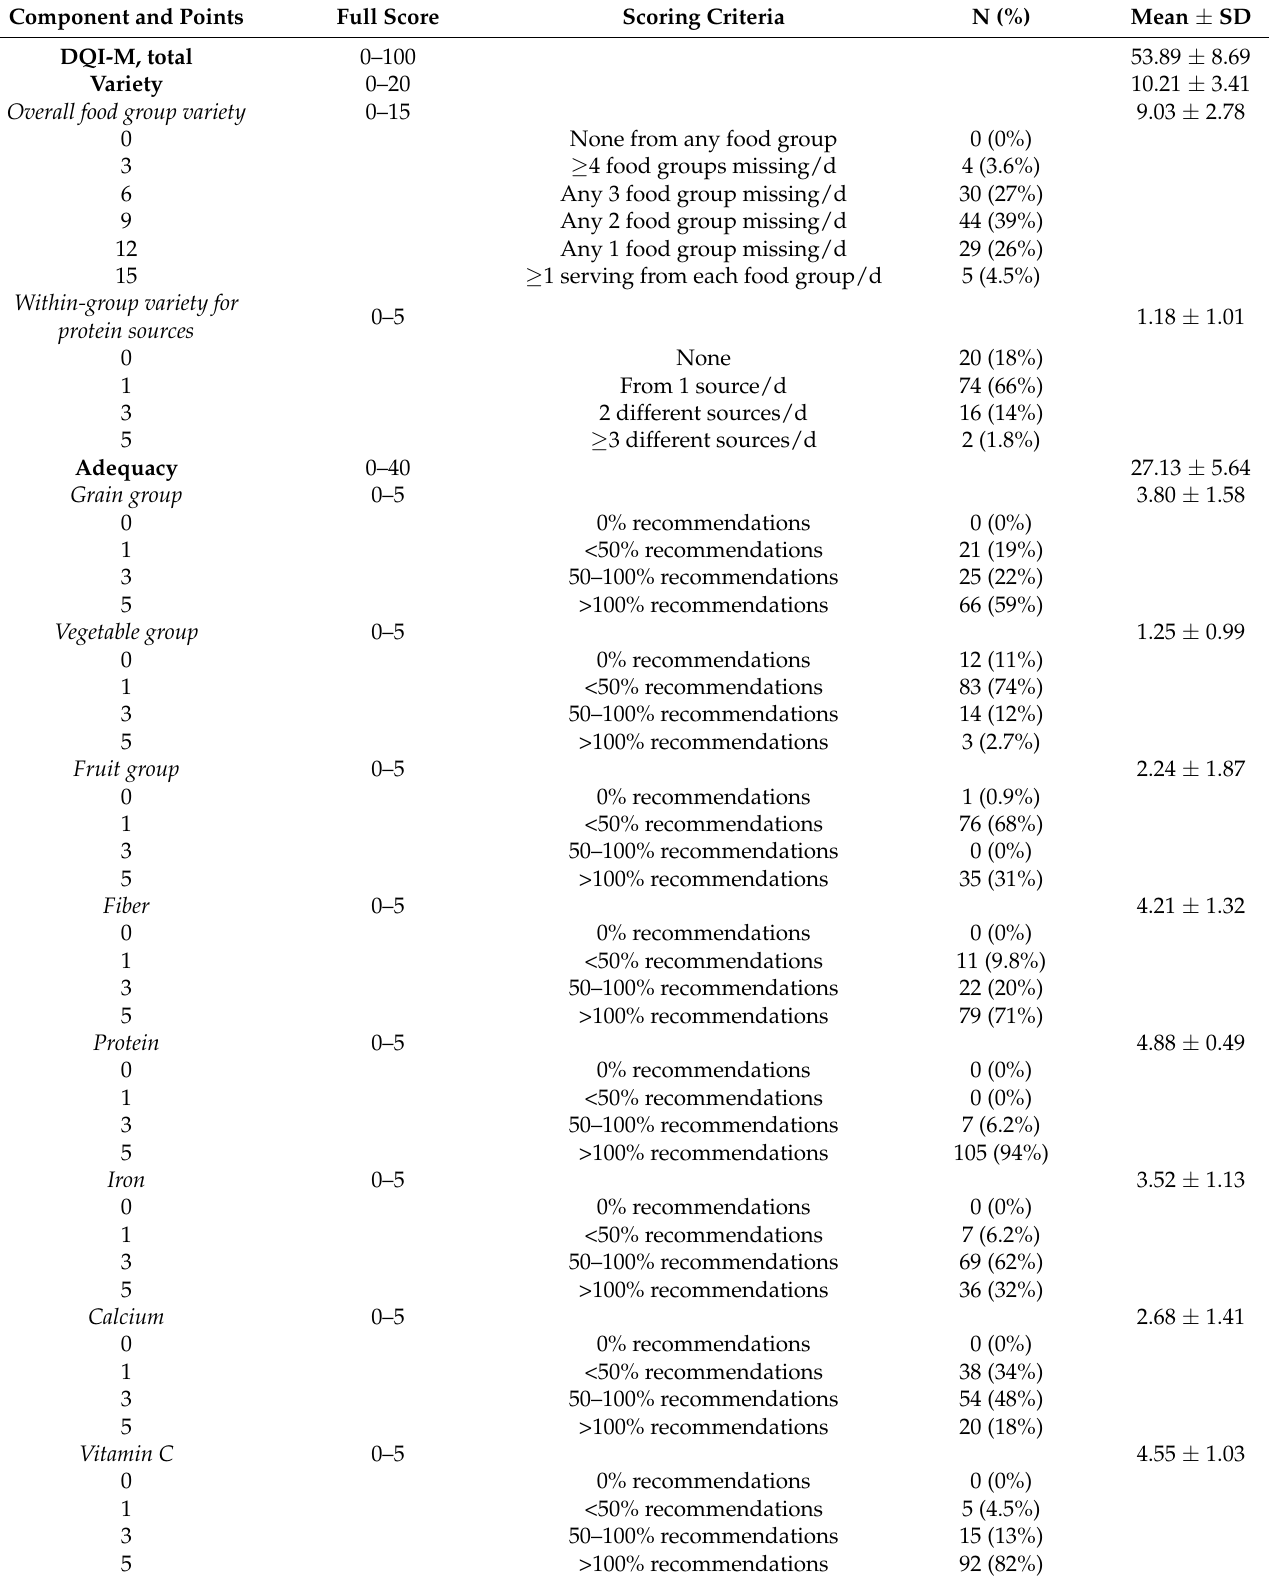
Table 3. Components of Diet Quality Index-International (DQI-I), percentage of the study population in component subcategories and respective